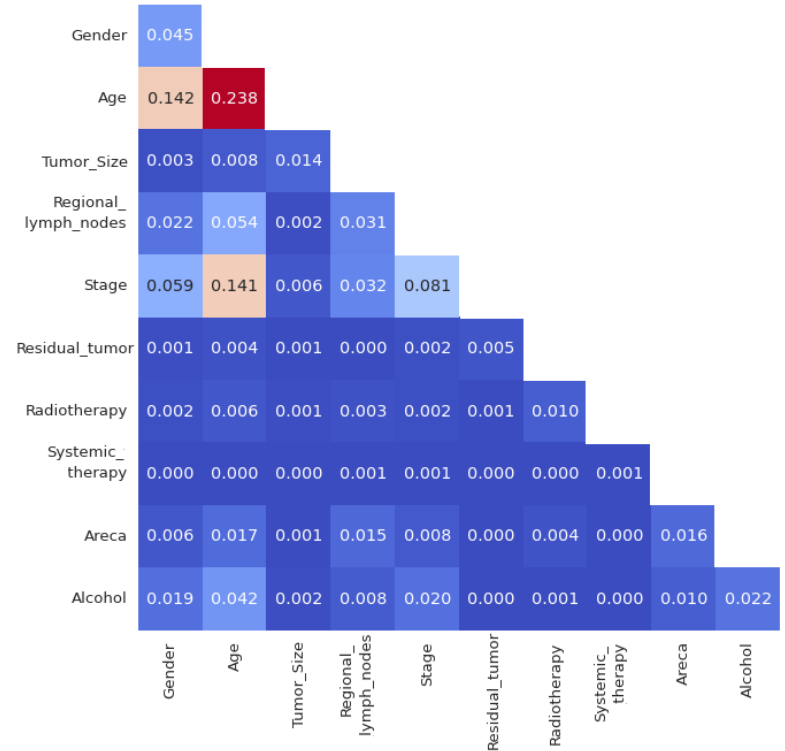
Figure 7. Heat map of the SHAP interaction values between the features.